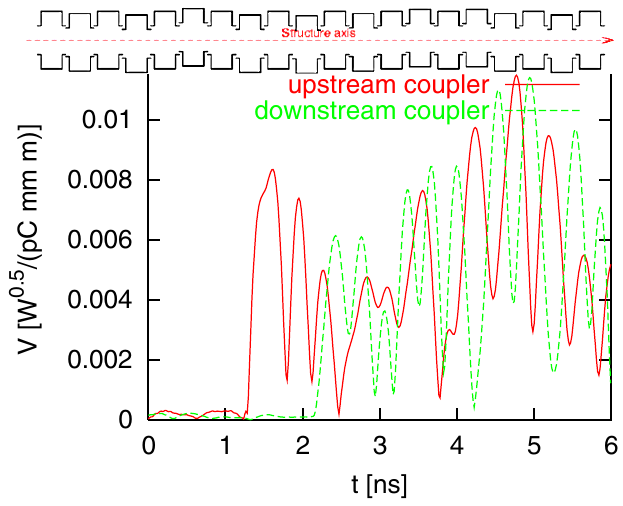
FIG. 13. (Color) Signal envelope upstream and downstream monitors vs time assuming random, uncorrelated misalignment of individual cells in the structure. The signal value is normal- ized to the standard deviation of the misalignments (1 mm